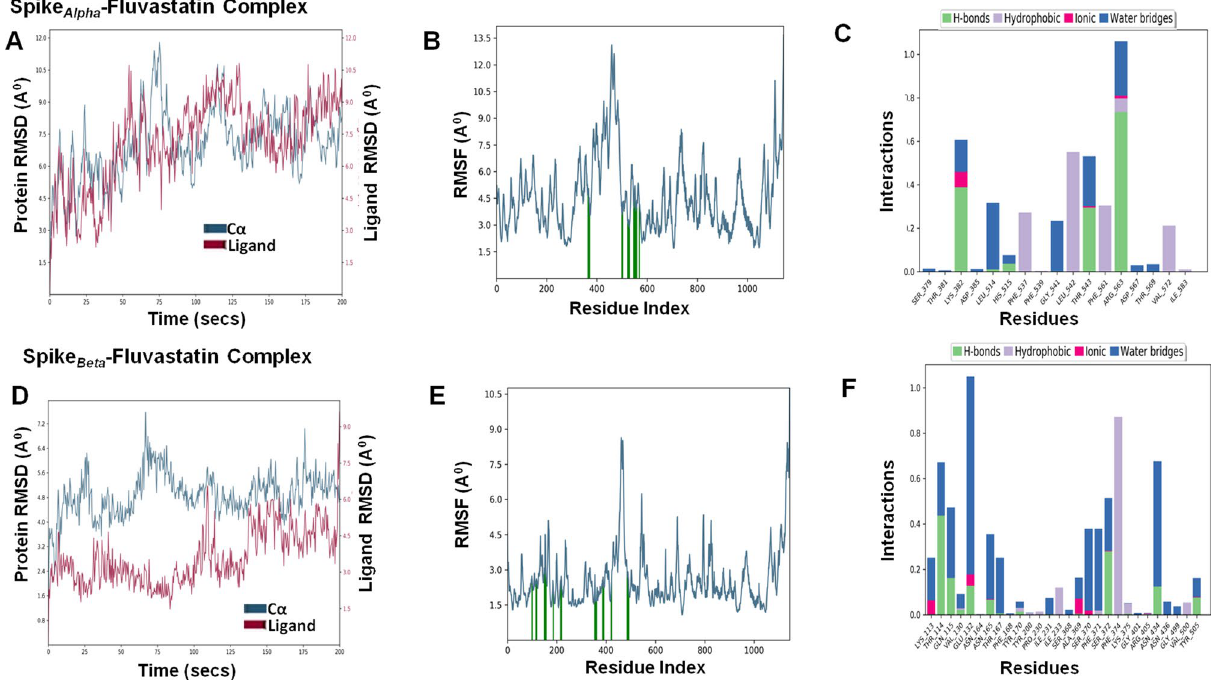
Figure 11. Molecular dynamic simulations of Spike Alpha –fluvastatin complex (A–C) and Spike Beta –fluvastatin complex (D–F) , respectively. (A–C) RMSD, RMSF, and protein–ligand interactions of Spike Alpha –fluvastatin complex, respectively. (D–F) RMSD, RMSF, and protein–ligand interactions of Spike Beta –fluvastatin complex, respectively.